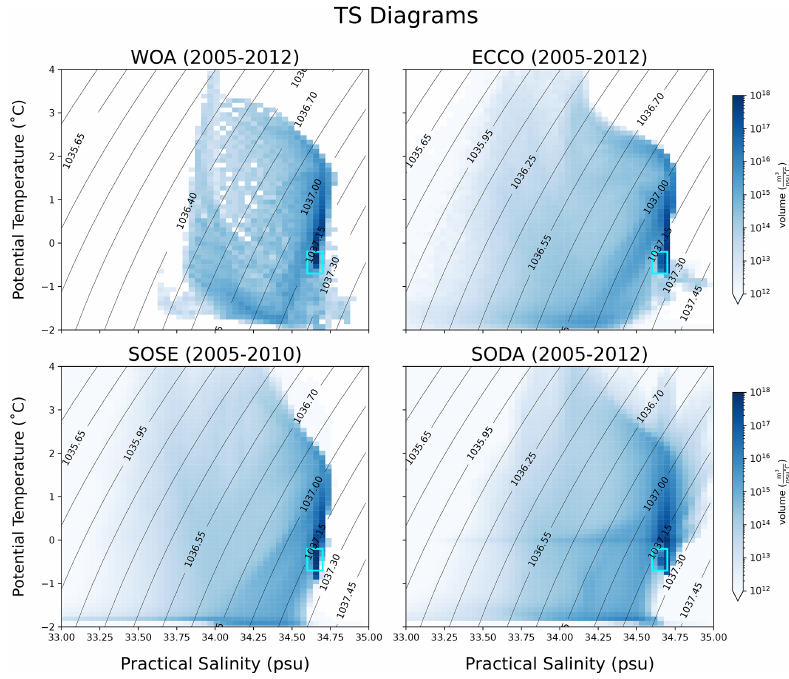
Figure 3. Averaged temperature–salinity distribution of the WG region for WOA, ECCO, SODA (2005–2012) and SOSE (2005–2010). Contour lines represent potential density referenced at 2000m ( σ 2 ). The cyan box shows the temperature–salinity range of AABW.